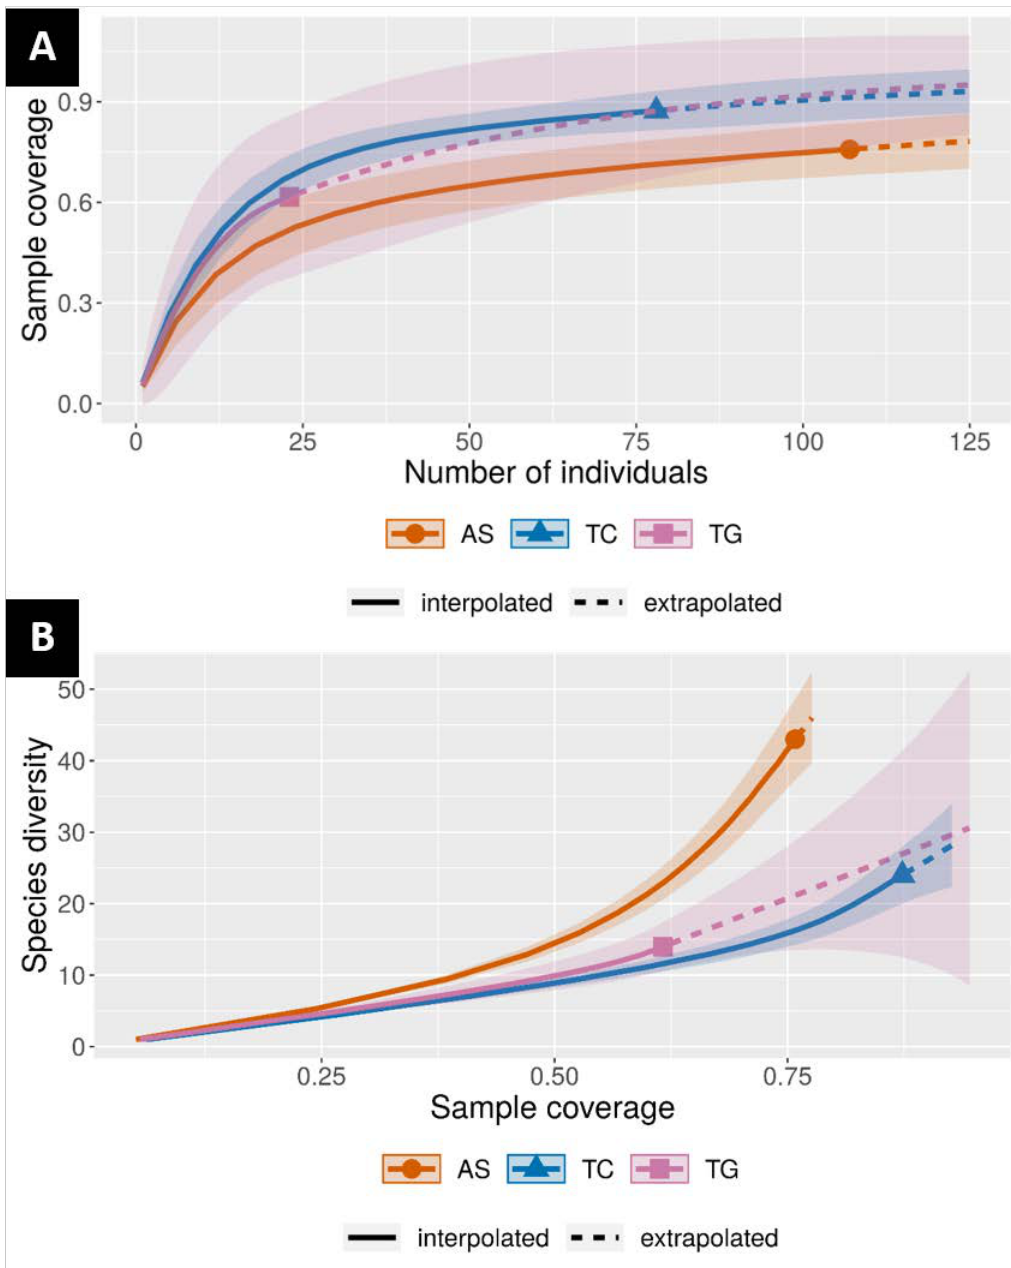
Figure 3. Non-asymptotic approach based on interpolation and extrapolation of species diversity and sample coverage based on iNEXT online software (http://chao.stat.nthu.edu.tw, accessed on 6 July 2021) as reported by Chao et al. [44]. Solid lines represent rarefaction of the sampling curves, the observed sampling effort; dotted lines represent extrapolation of the sampling curves, based on Hill numbers for q = 0.1 and 2. ( A ) Sample completeness curve according to host tree species. ( B ) Coverage-based rarefaction and extrapolation sampling curve according to the host tree species. Legend: AS = A . spirorbis ; TC = T . calobuxus ; TG = T. guillainii